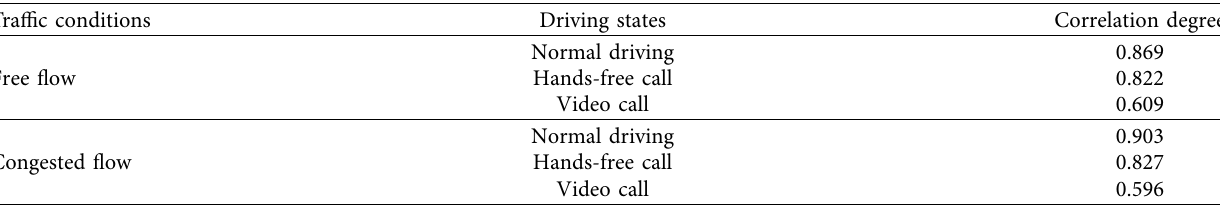
diferent degrees compared with normal driving, and the VSC was more sensitive to the infuence of video call op- eration, resulting in a sharp decrease in the correlation degree. Te correlation degrees of diferent driving states were consistent with the variation rule of mean VSC, which further verifed the validity of the assessment results of VSC.